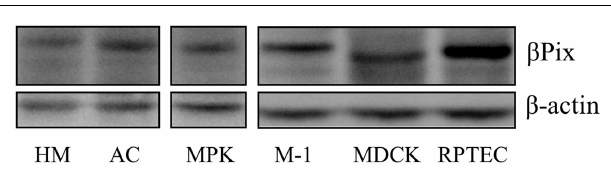
FIGURE 5 | β Pix expression in kidney cells lines. Western blot analysis of cultured kidney cells reveals the ubiquitous expression of β Pix.The data presented for proteins extracted from immortalized human mesangial cells (HM), human renal carcinoma 786-O cells (AC), immortalized mouse cortical collecting duct principal cells (mpkCCD c14 and M-1), Madin–Darby canine kidney cells (MDCK) and renal proximal tubule epithelial cells (RTEC). Equal amount of protein loaded in each lane was verified by western blot with anti- β -actin antibodies (reproduced from Pavlov et al., 2010 with permission).